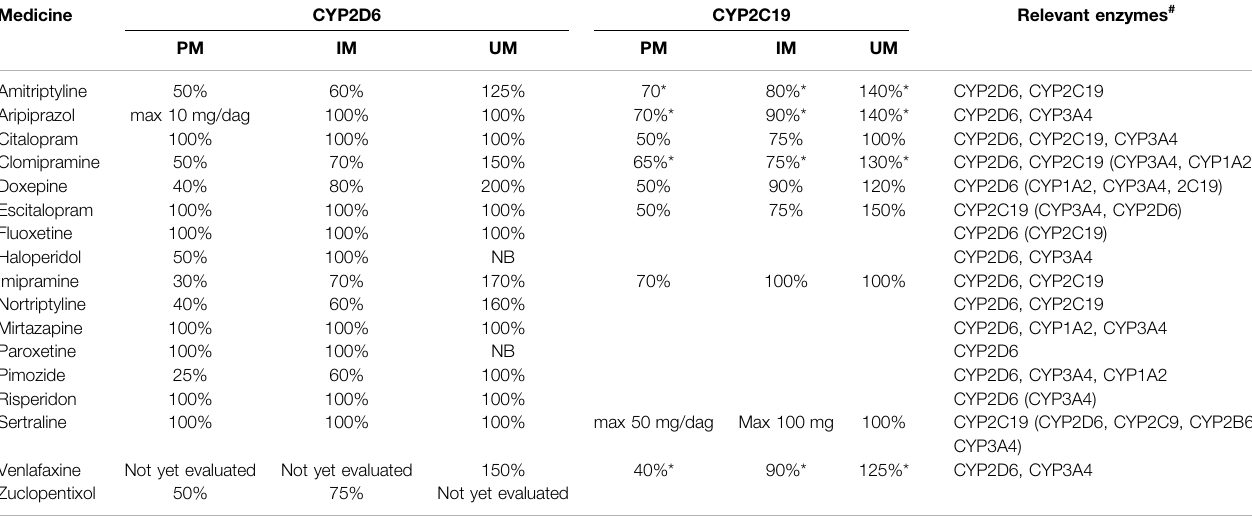
TABLE 3 | Effect of genotyping on dosage, indicated as percentage of commonly prescribed dosage, as indicated by KNMP (01-01-2019) or Stingl et al. (2013). Medicine Relevant enzymes